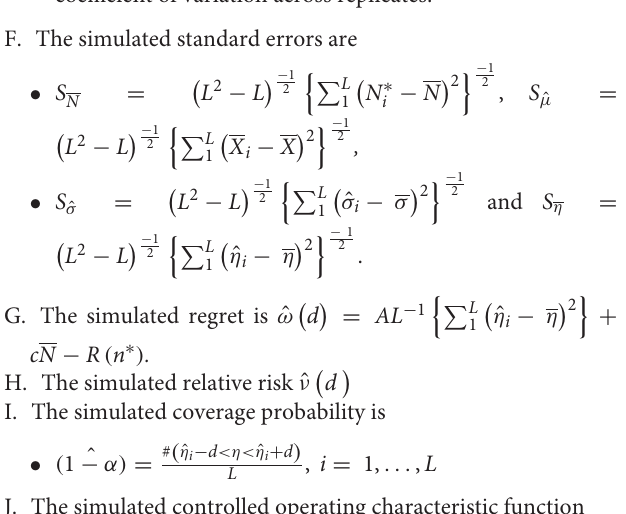
5, 10, 20 m 15, γ 0.5, α 5 % = = = =